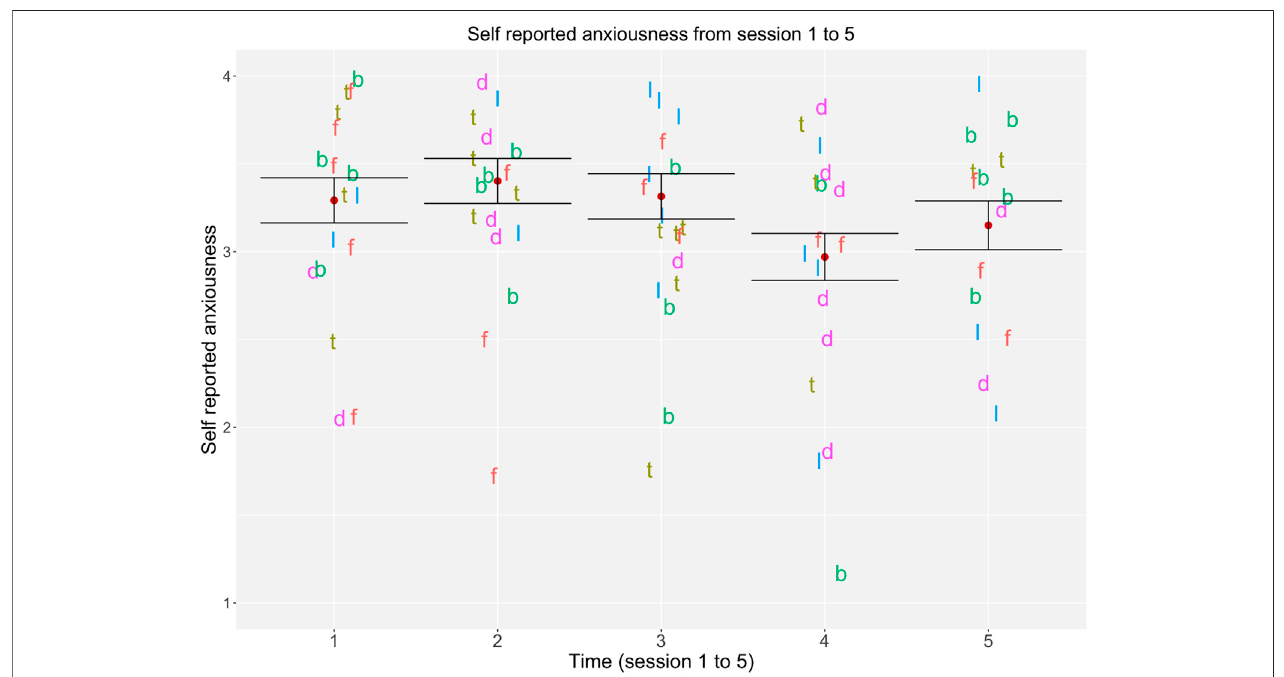
FIGURE 4 | Anxiousness reported by participants for each session (1: De fi nitely, 2: Slightly, 3: Slightly not, 4: De fi nitely not). Letters shows task names (f: fi shing, t: twenty questions, b: brainstorm, l: lifeboat, d: draw and guess). Red dots represent mean and black bars show standard error of the mean. For this plot items were reverse coded to make interpretation easier.